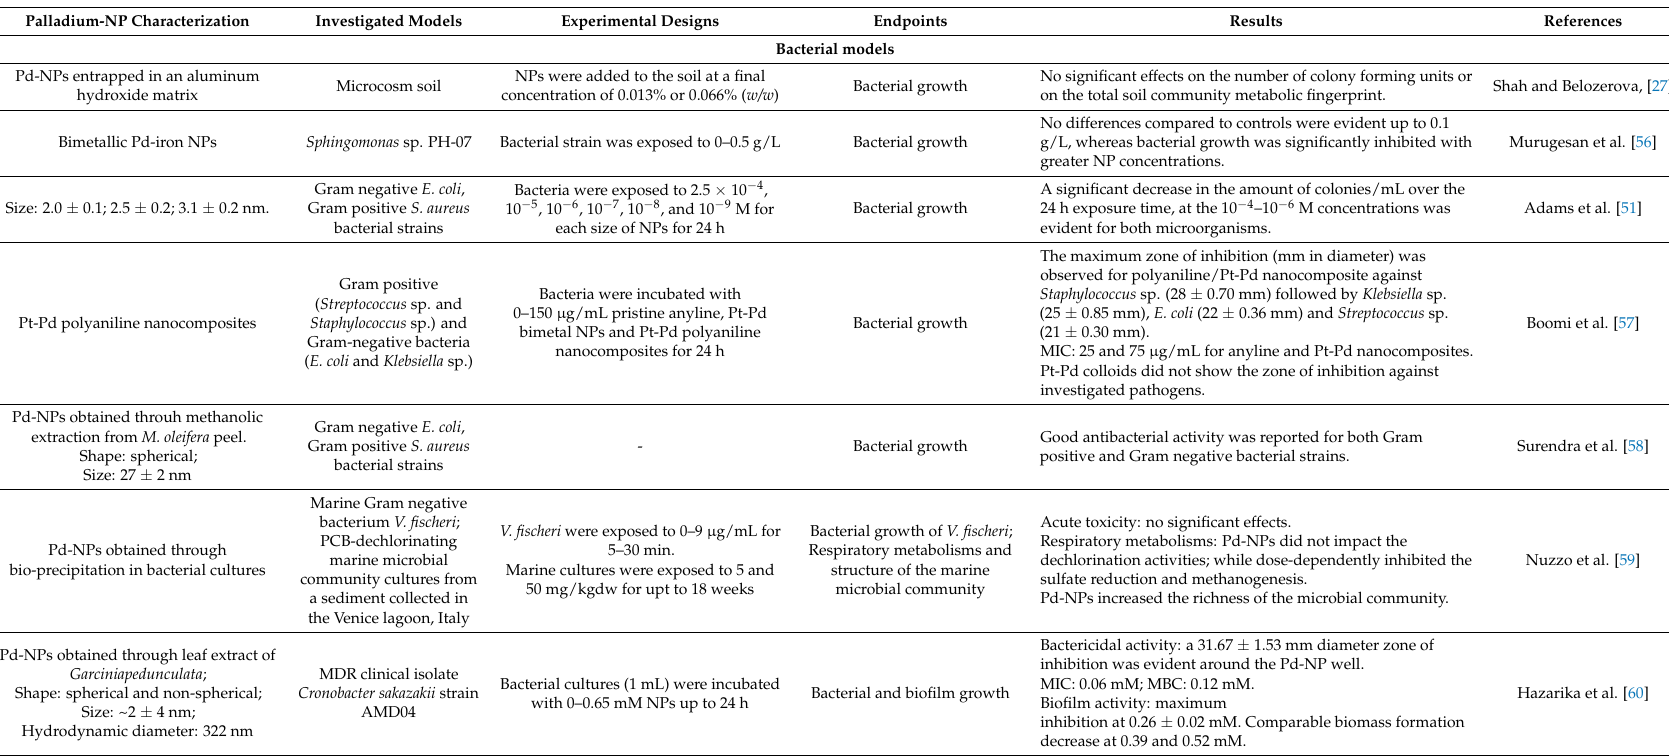
Table 2. Studies investigating the effects of Pd-NPs on in vivo